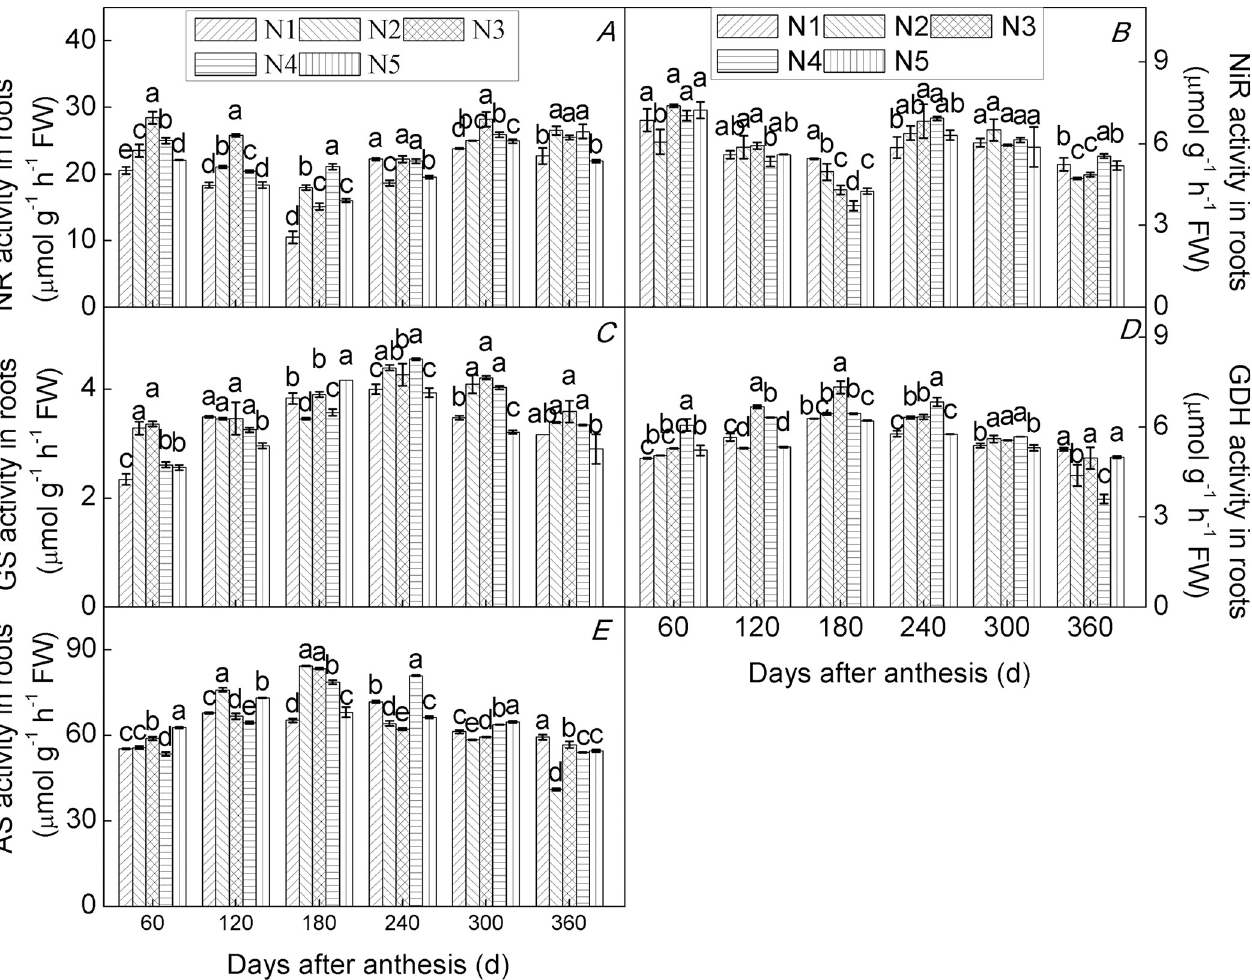
Fig 6. Relative enzyme activity in roots of the citrus cultivar ‘Huangguogan’. NR (Nitrate reductase, A), NiR (nitrite reductase, B), GS (glutamine synthetase, C), GDH (glutamate dehydrogenase, D) and AS (asparagine synthetase, E). N 1 : 0, N 2 : 1.36, N 3 : 1.81, N 4 : 2.26, N 5 : 2.72 kg N/ year [CO(NH 2 ) 2 , N � 46.67%].